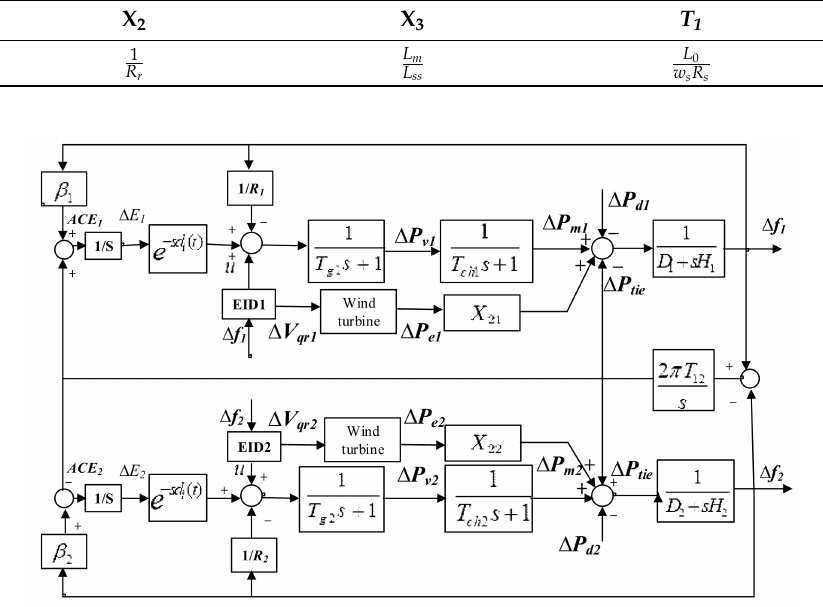
Figure 1. A two-area wind integrated power system for equivalent input disturbances (EID) based load frequency control (LFC).